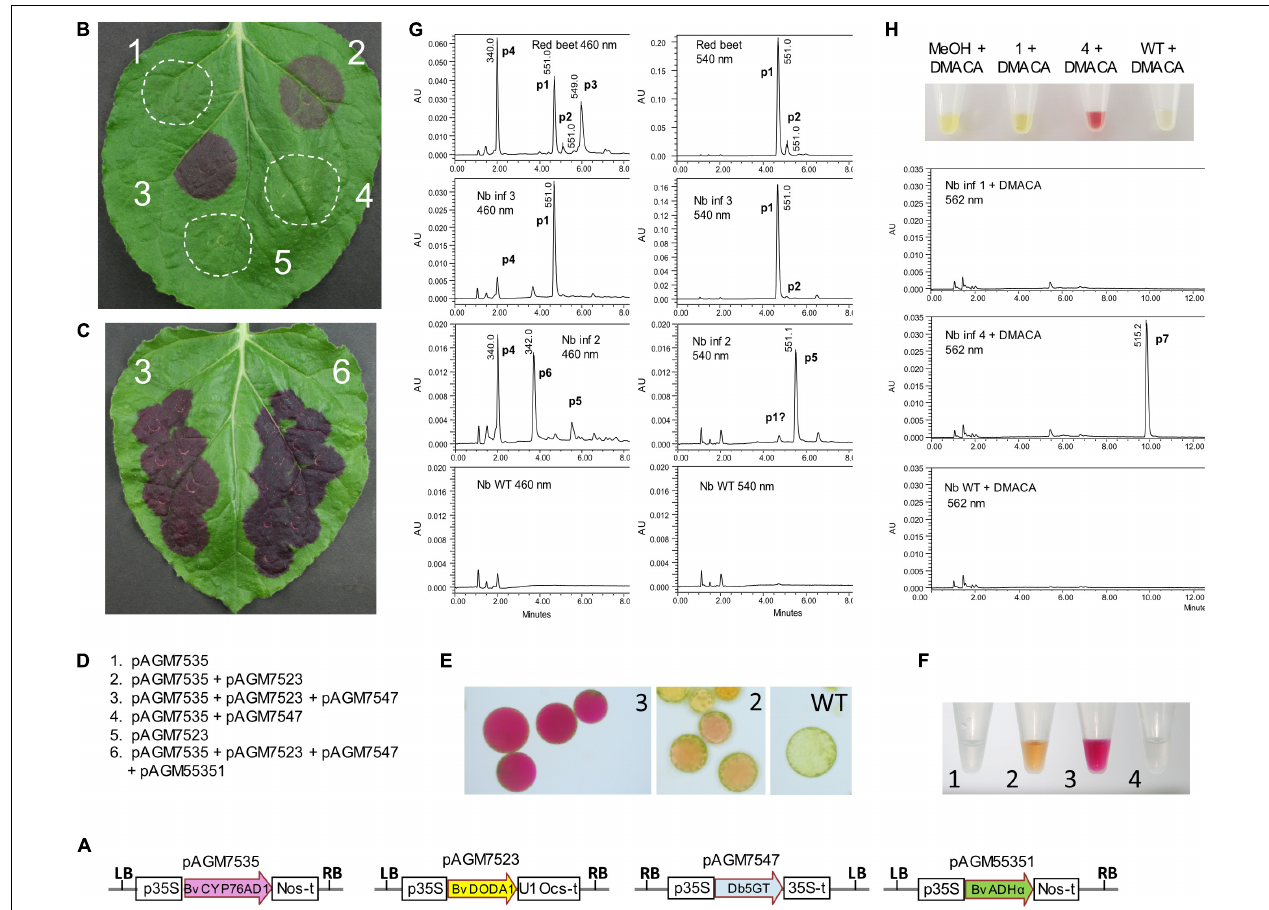
FIGURE 2 | Betalain biosynthesis by transient expression in Nicotiana benthamiana leaves. (A) Structure of the level 1 constructs for transient expression of the genes involved in betalain biosynthesis. p35S, 35S promoter; Nos-t, Nos terminator; U1 Ocs-t, 3 (cid:48) untranslated sequences from TMV U1 viral genome followed by Ocs terminator; 35S-t, 35S terminator; LB and RB, left and right T-DNA borders. (B,C) Transient expression of the level 1 constructs in N. benthamiana leaves. Pictures taken 5 days after infiltration. (D) Description of the combination of constructs infiltrated in the leaves shown in (B,C) . (E) Protoplasts prepared from infiltrations 2 and 3 from (B) and from WT non-infiltrated tissue. (F) Extracts from infiltrations 1 to 4 from (B) . (G) LC/MS analysis of extracts 2 and 3 shown in (F) and of a beetroot sample as a control. Note that the scale range (AU) is not the same for all samples. Identified peaks with the same retention time across runs: